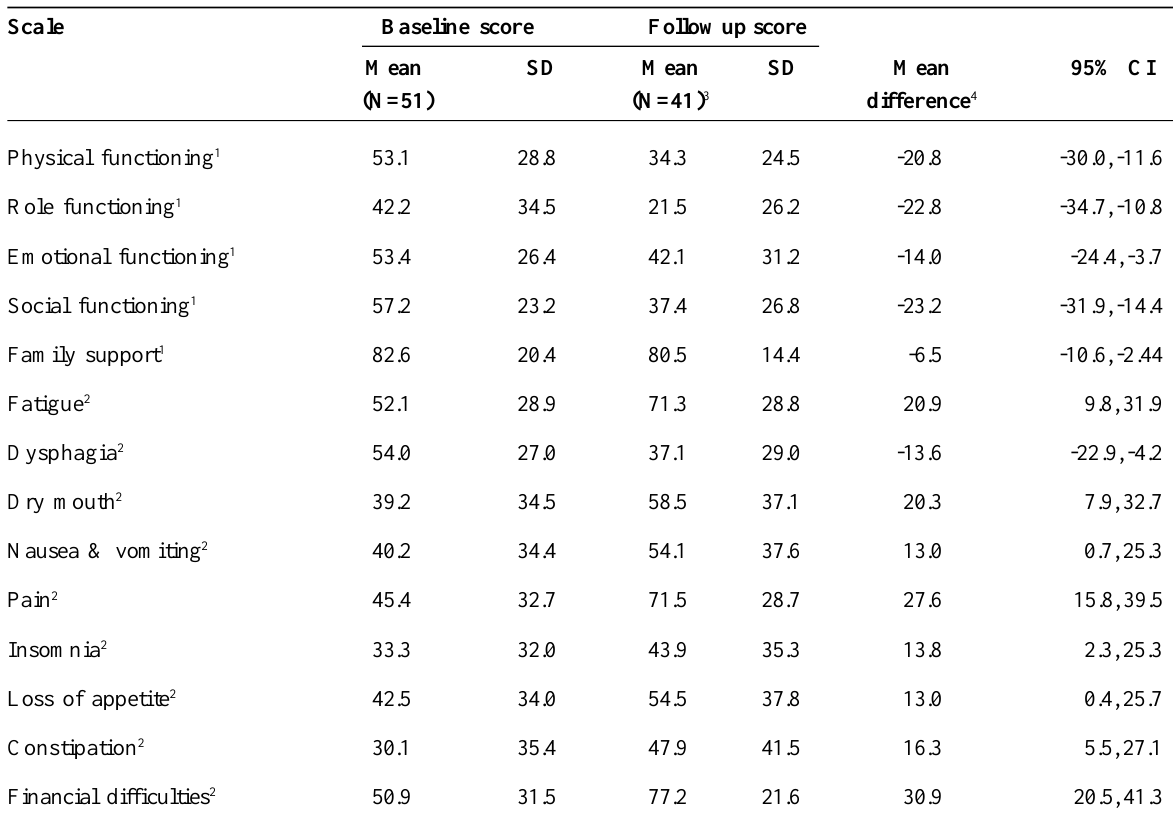
Table 3. The dimensions in QoL that showed a significant change after initial treatment Scale Baseline